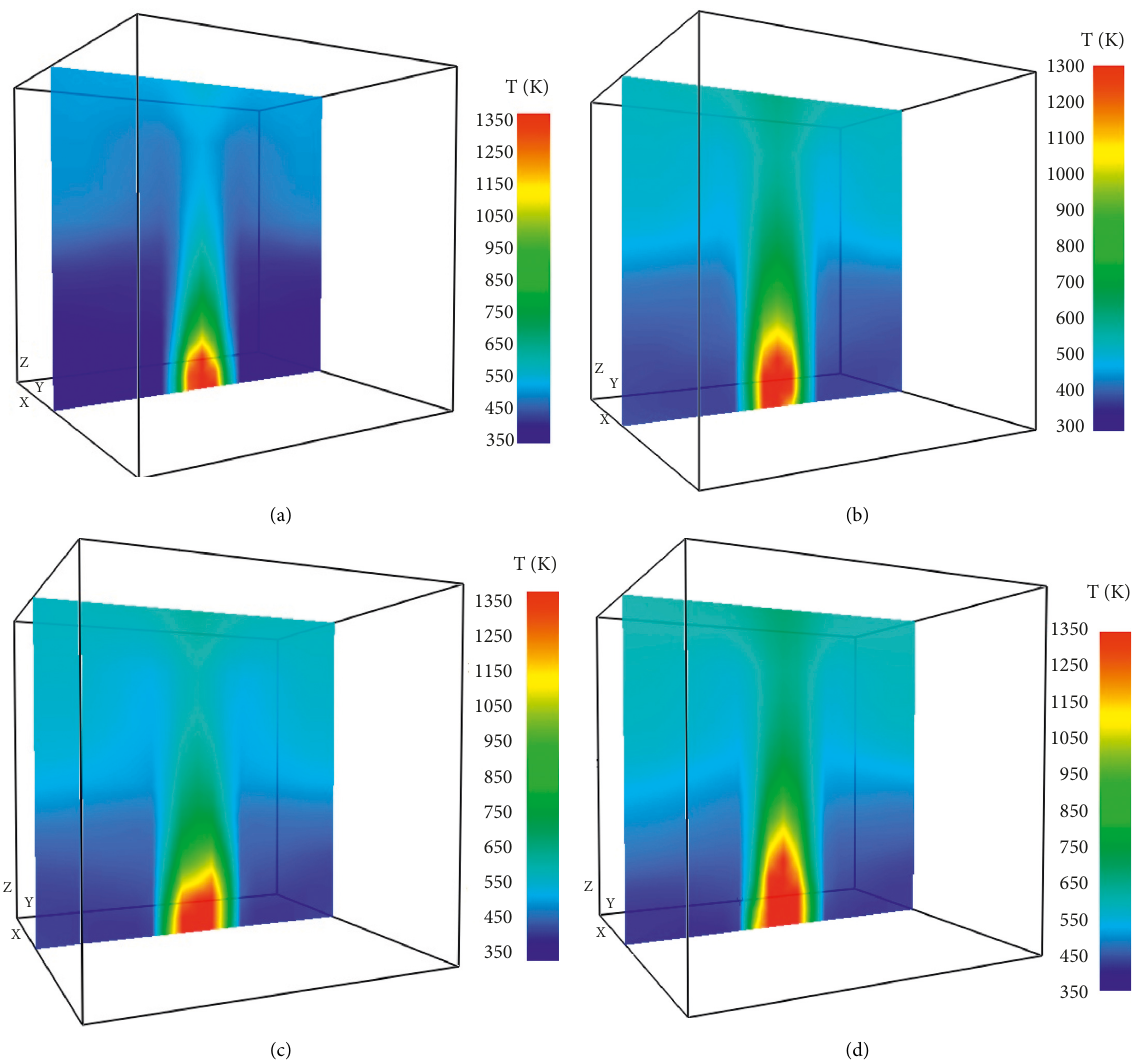
Figure 8: Temperature fields of flame at plane x � 0.2 during the full development phase (at time t � 400sec). (a) Fire scene 1. (b) Fire scene 2. (c) Fire scene 3. (d) Fire scene